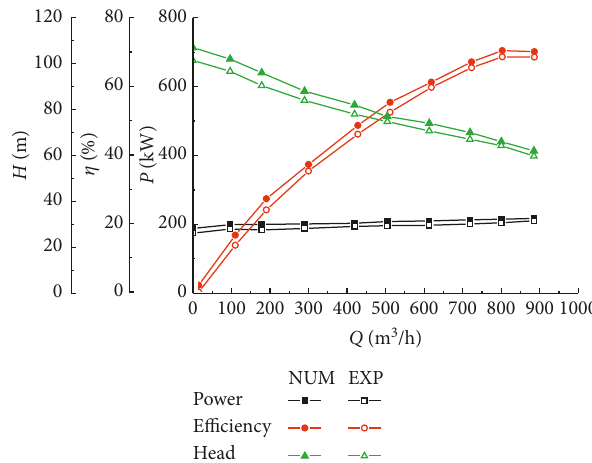
Figure 7: Characteristic curves of the two-stage electric lifting